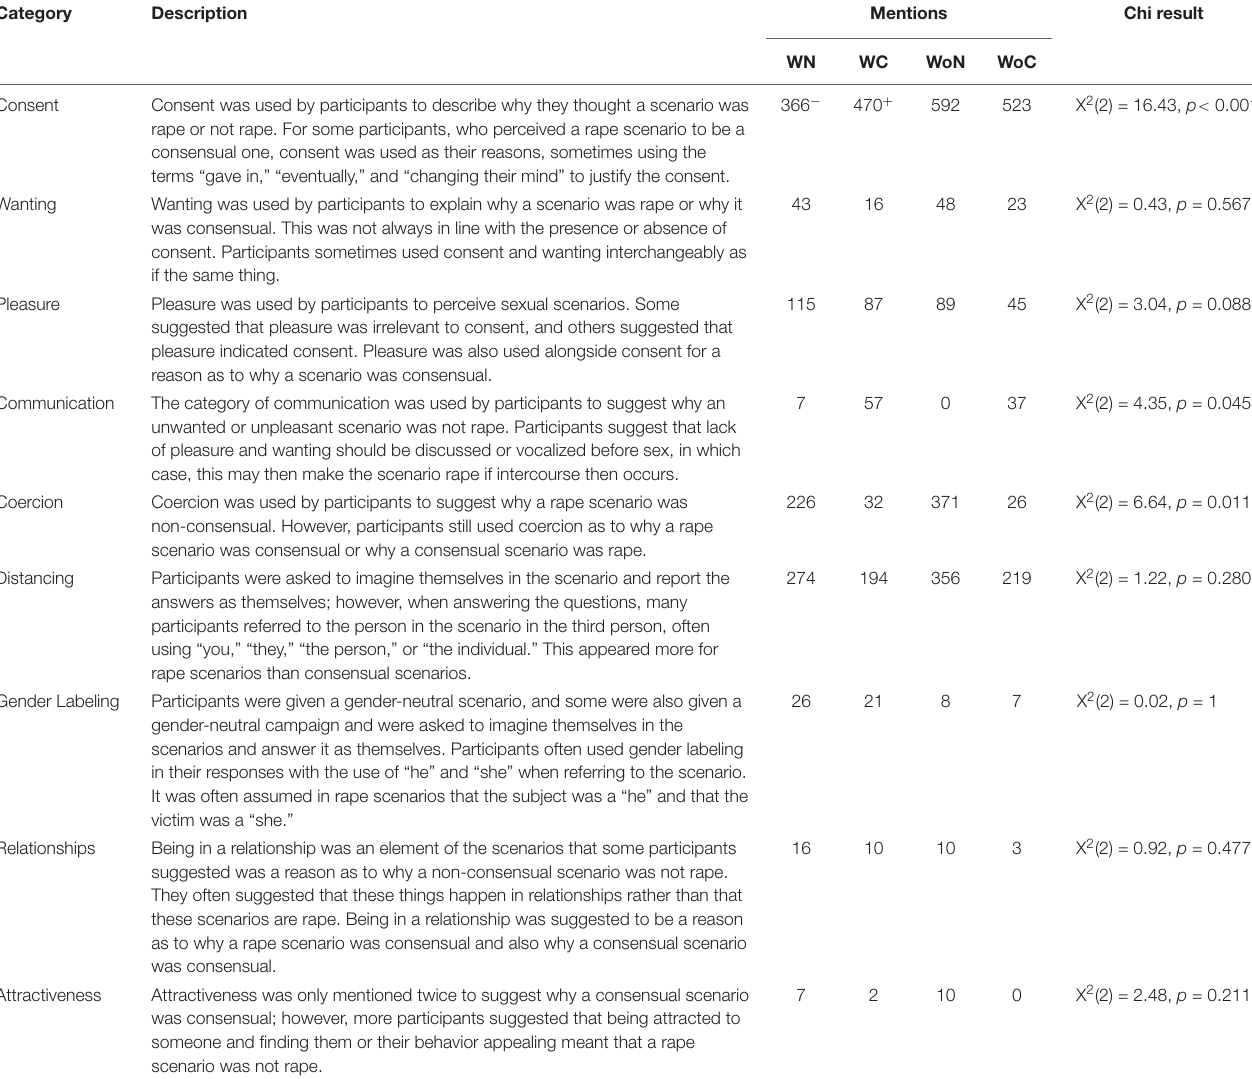
TABLE 1 | Summary content analysis (full analysis presented in Supplementary Table S1 ) for the question “Please explain why you think this scenario is rape or not